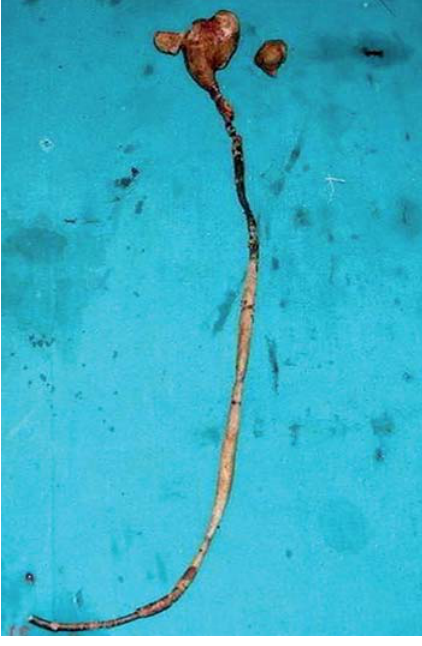
Figure 3 – Retrieved stent with extensive calcification. This patient had a retained stent for 9 years. Open surgery was required to remove the